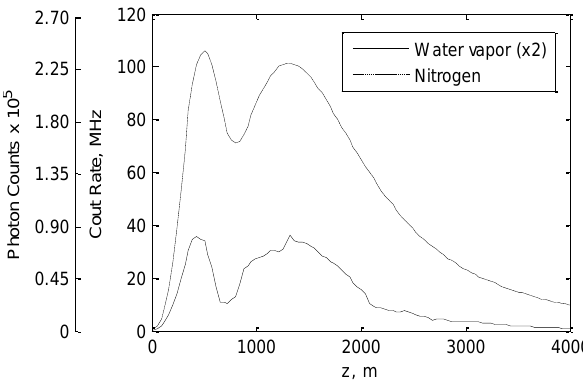
Fig. 11. Lidar signals from water vapor and nitrogen